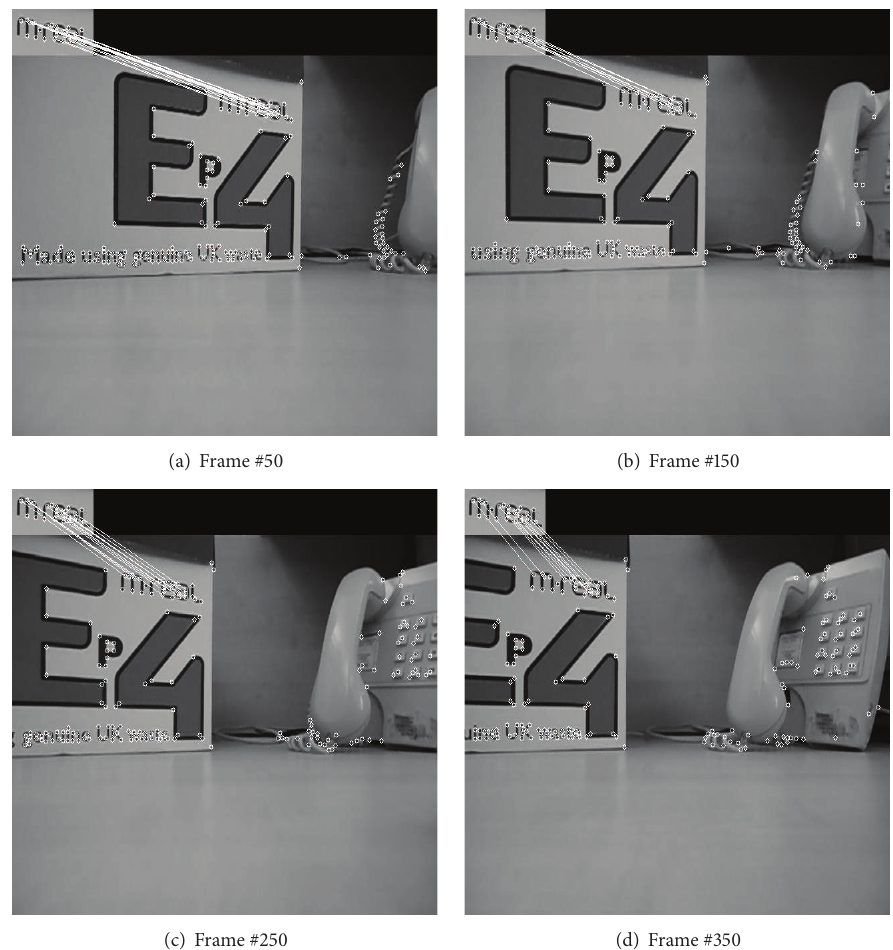
Figure 14: Template is successfully matched in whole video; however, some equally spaced frames are shown